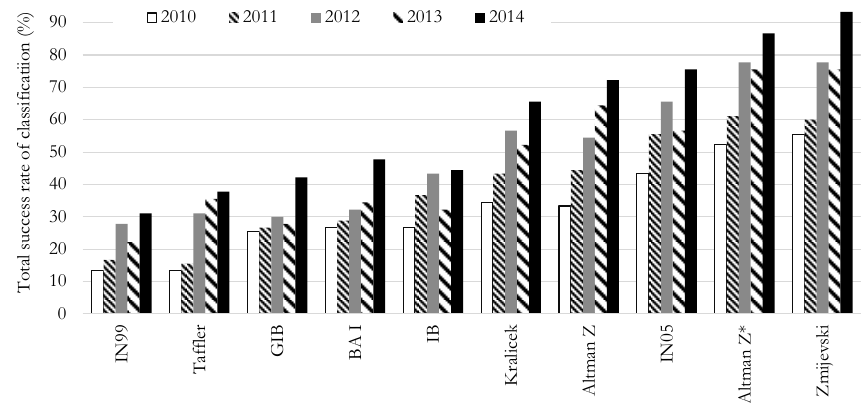
Fig. 3 – Evaluation according to the total success rate in the years 2010-2014 (%). Source: own research In addition to the confusion matrix, ROC curves are used to evaluate the accuracy of the